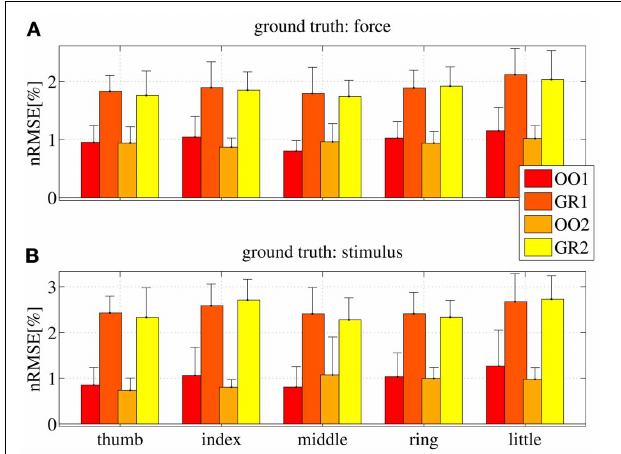
FIGURE 10 | nRMSE for all subjects, when training on an on-off phase and testing on a graded phase. The legend denotes the training/testing phase, e.g., OO1/GR2 means that ridge regression was evaluated with data gathered during the first on-off phase, and the prediction was tested on data gathered during the second graded phase. (A) With the force as ground truth; (B) with the stimulus as ground truth. Each bar and stem represents the mean nRMSE and standard deviation obtained over all